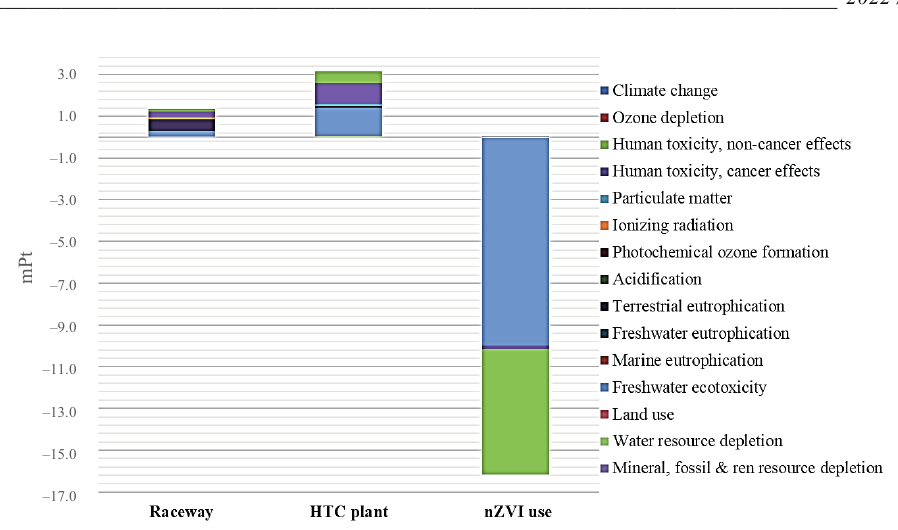
Fig. 4. Contribution of the different sections to the overall impact of the foreseen system.